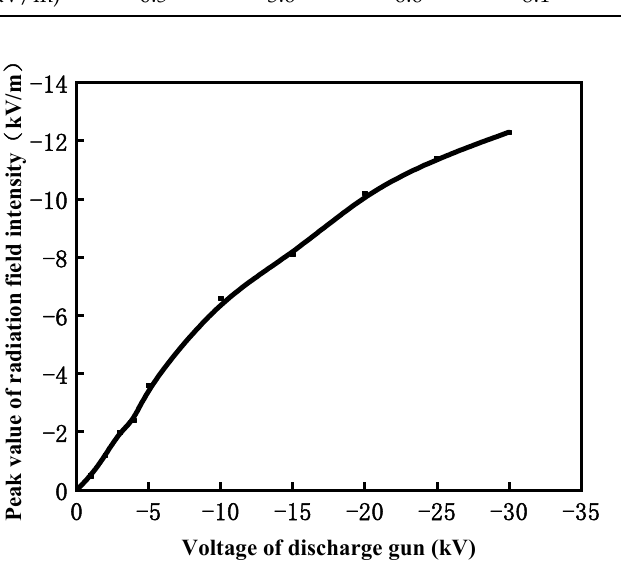
Figure 6. Variation trend of peak value of ESD field with discharge gun voltages.